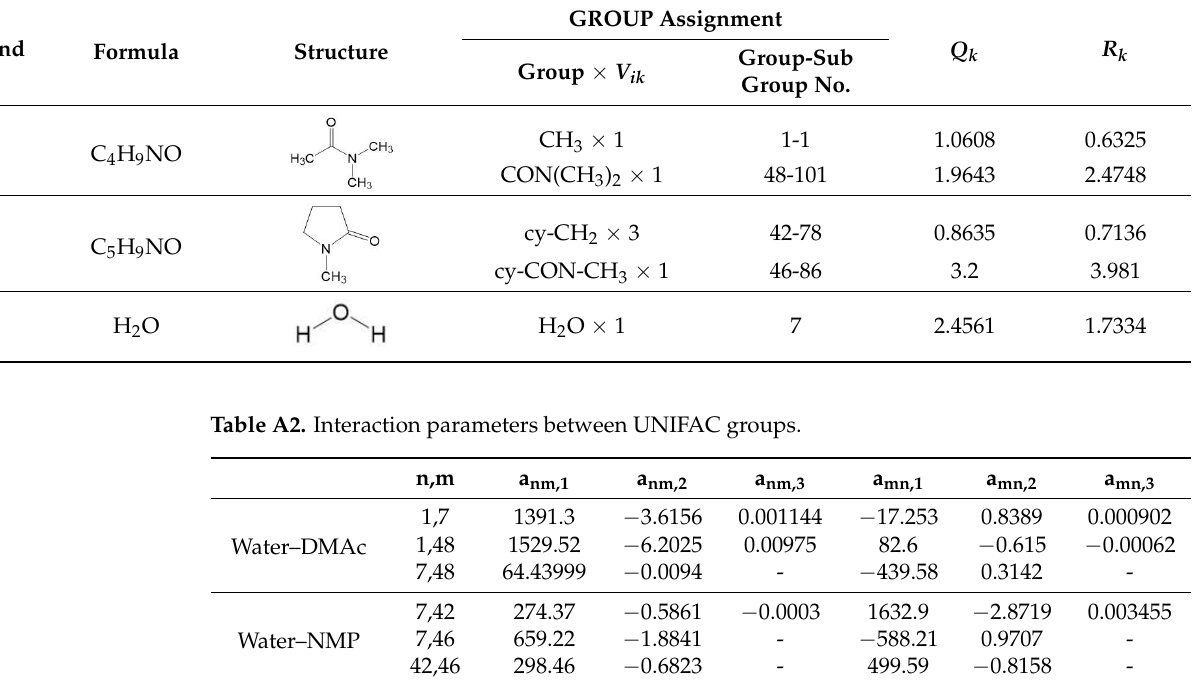
Table A3. Average values of cloud point data at the three temperatures for the four studied systems.